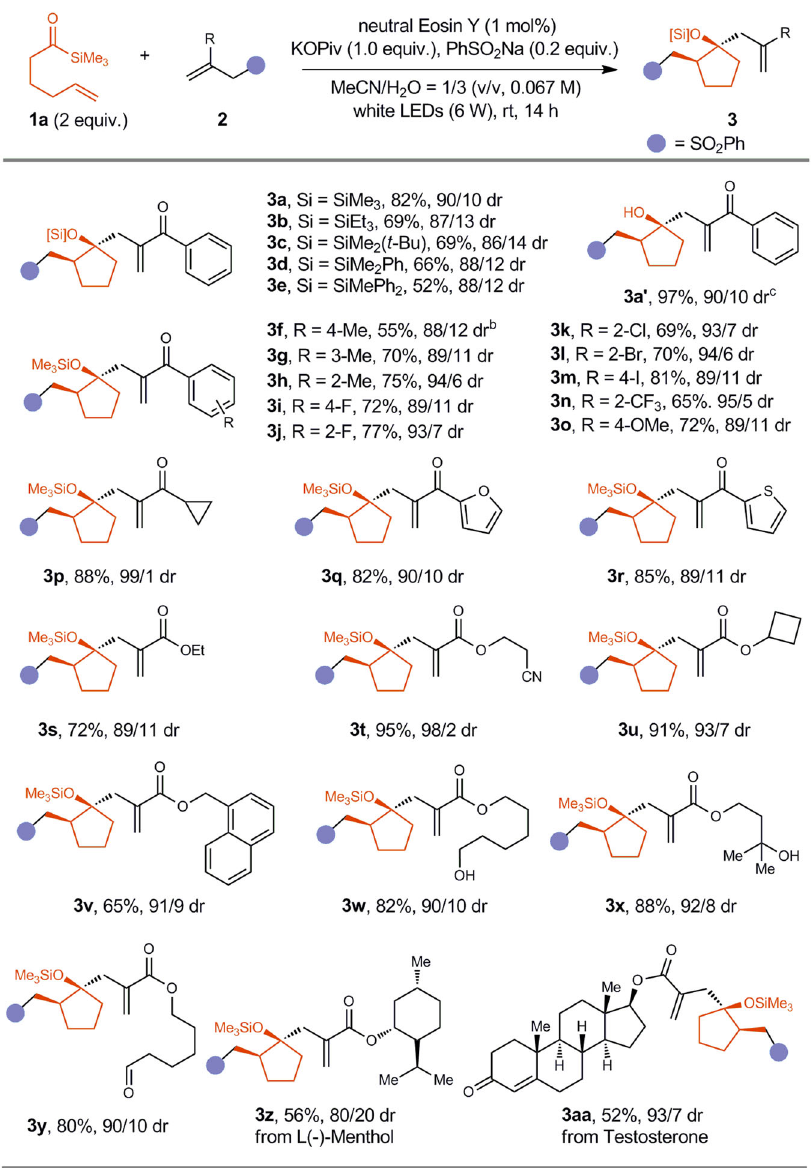
Fig. 3 | Scope for the synthesis of β -substituted cyclopentanol derivatives. a Total yield of the isolated two diastereoisomers is reported. b neutral Eosin Y